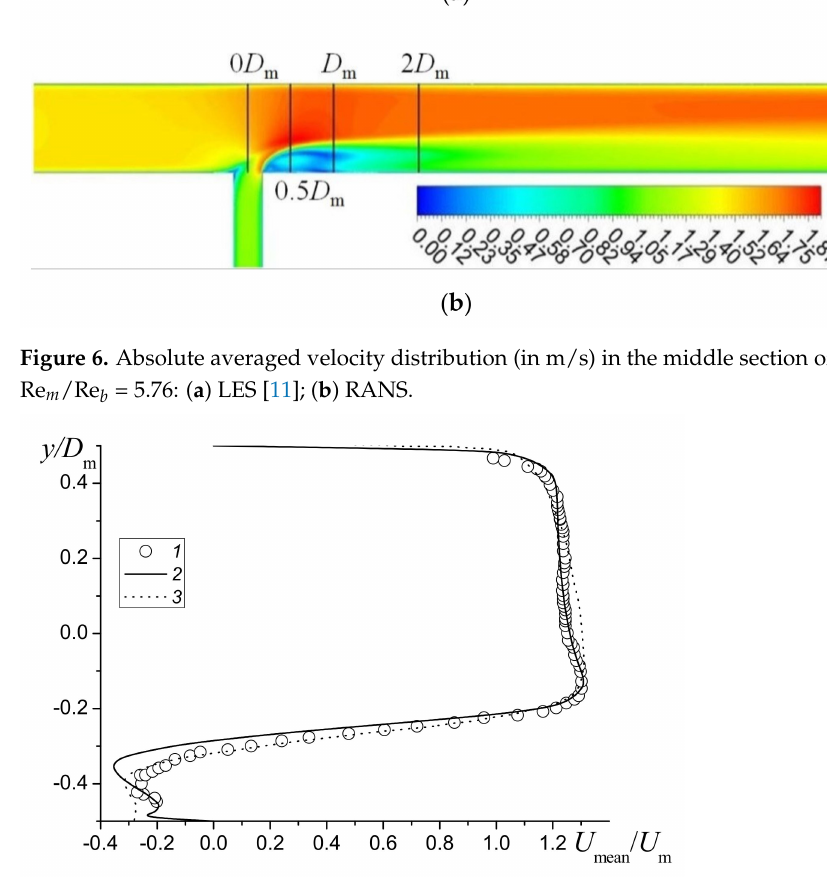
Figure 7. Distribution of the dimensionless velocity U mean / U m in the section at the distance behind the socket center for Re m /Re b = 5.76: ( 1 ) WATLON experiment [10]; ( 2 ) RANS; ( 3 ) LES